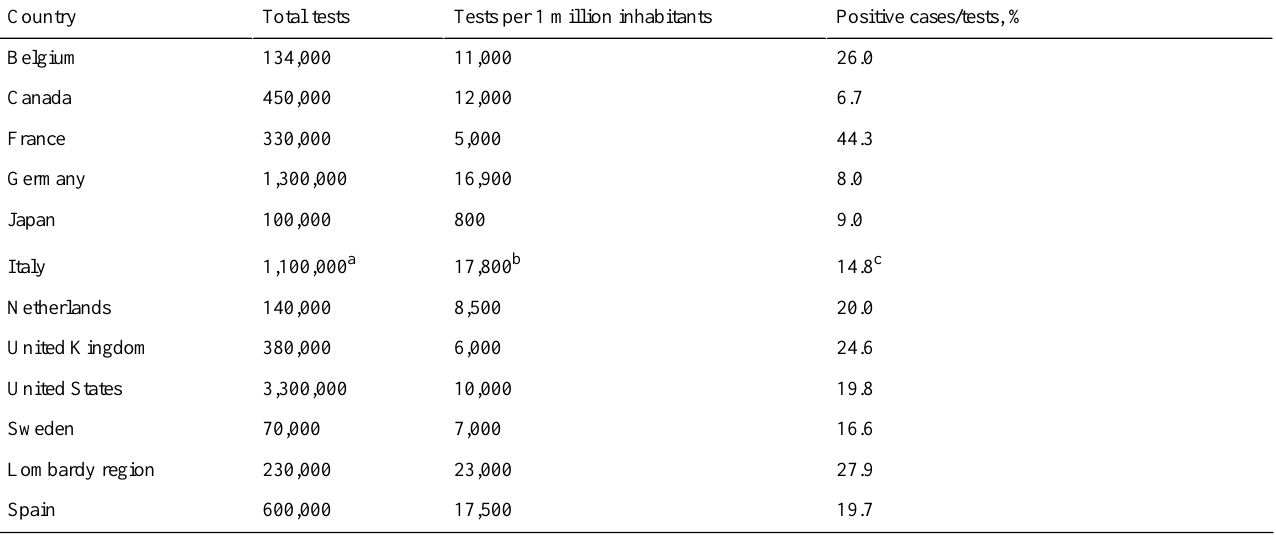
Table 2. COVID-19 testing data for Italy and the Lombardy region and for the other G10 countries.